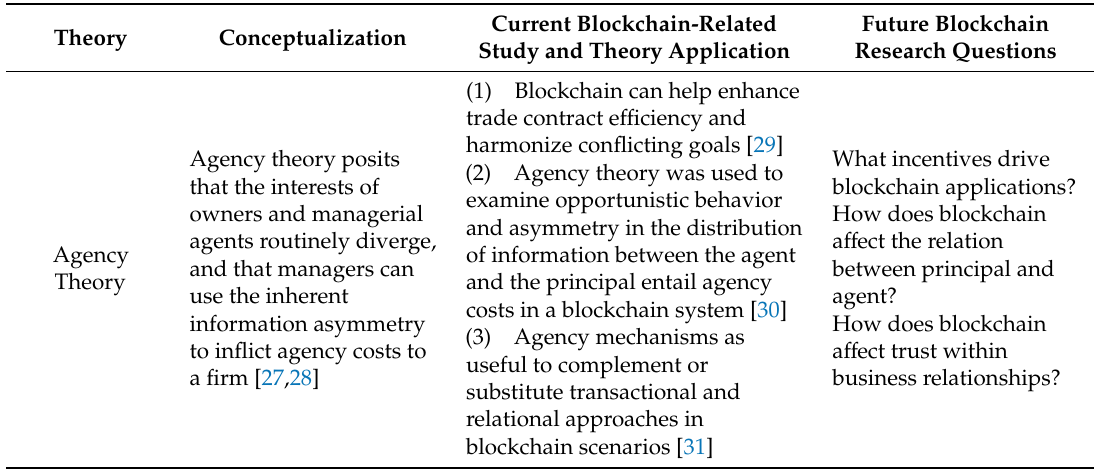
Table 4. Organizational theories in blockchain literature in the context of logistics and supply chain management